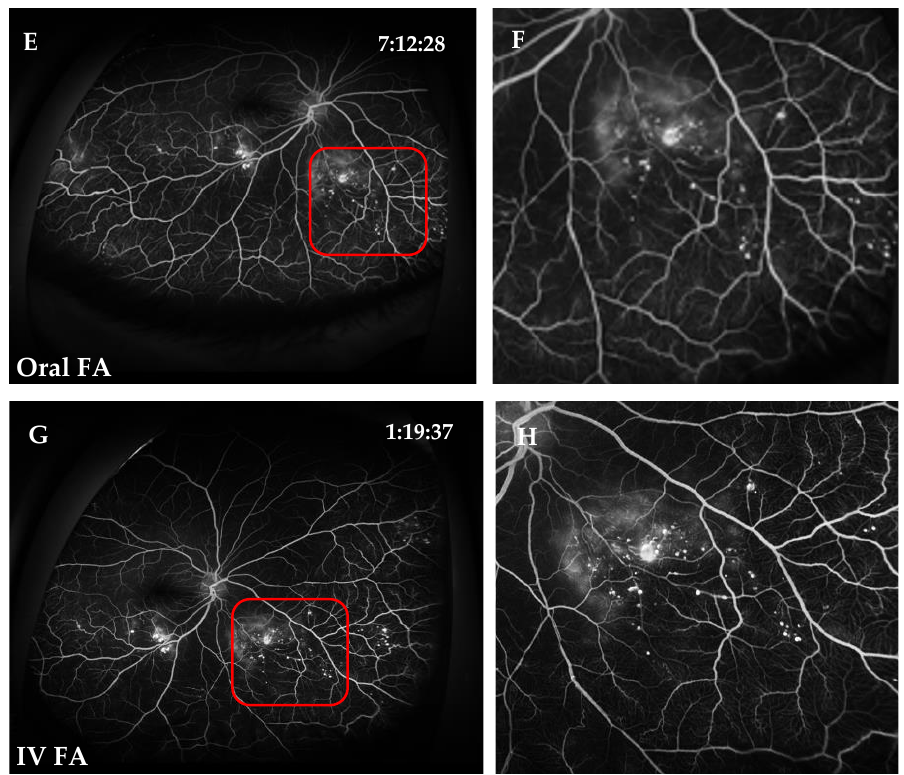
Figure 3. Representative images of the significantly nonperfused area, neovascularization, leakage, and microaneurysms of Oral FA and IVFA. ( A , B ) Oral FA image. ( C , D ) IVFA image. The nonperfused area with leaking telangiectatic vessels in the temporal peripheral retina is clearly visible in both oral FA and IVFA images. ( E , F ) Oral FA image of microaneurysms. ( G , H ) IVFA image of microaneurysms. Table 2. Detection rates of retinal vascular characteristics for oral FA and IVFA.